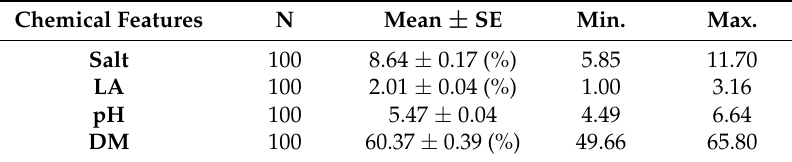
Table 2. Results of chemical results found in herby cheese